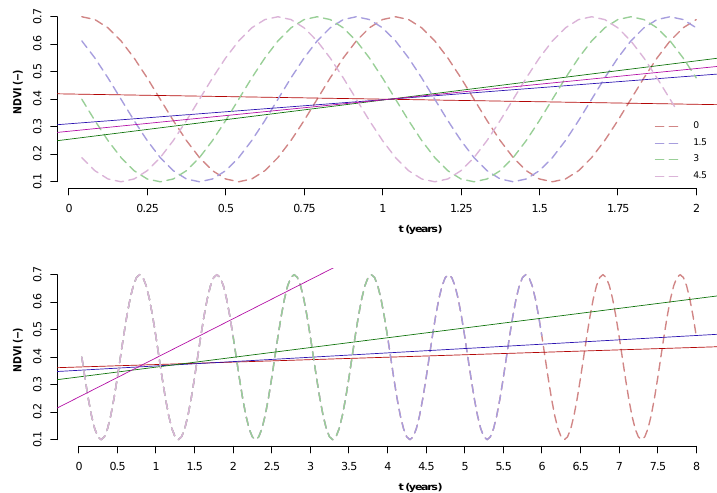
Fig. 1. The effect of phase shift (a) and extent (b) on linear regression of NDVI against time for seasonal data. The legend in (a) shows the phase shift in months. In (b) , the colors each represent an additional extent of 2yr. Accordingly, magenta, green, blue and red refer to extents of 2, 4, 6 and 8yr respectively.